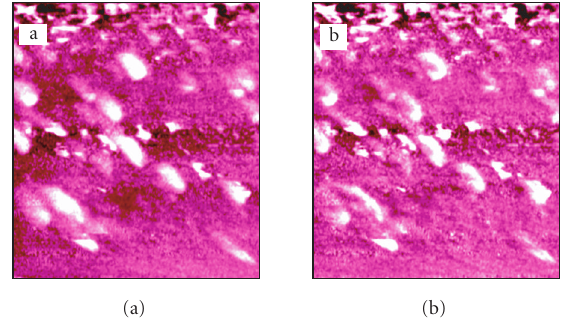
Figure 46: Simultaneous apertureless shear-force AFM (a) (5 μ m, Z range 200nm) and fluorescence SNOM (b) of nanoparticles in polyvidone resin showing the occurrence of both single and aggre- gated